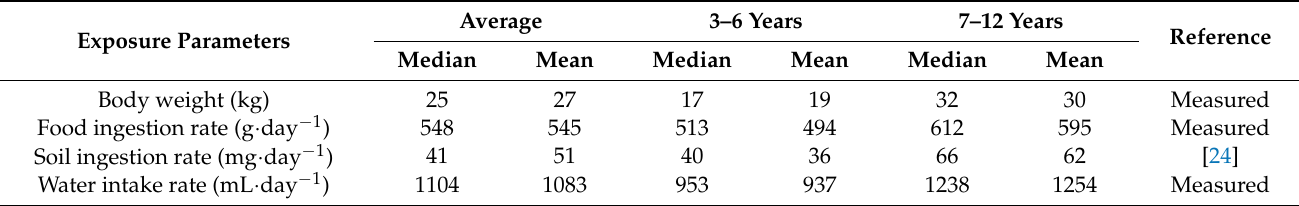
Table 1. Summary of exposure factors developed for the investigation